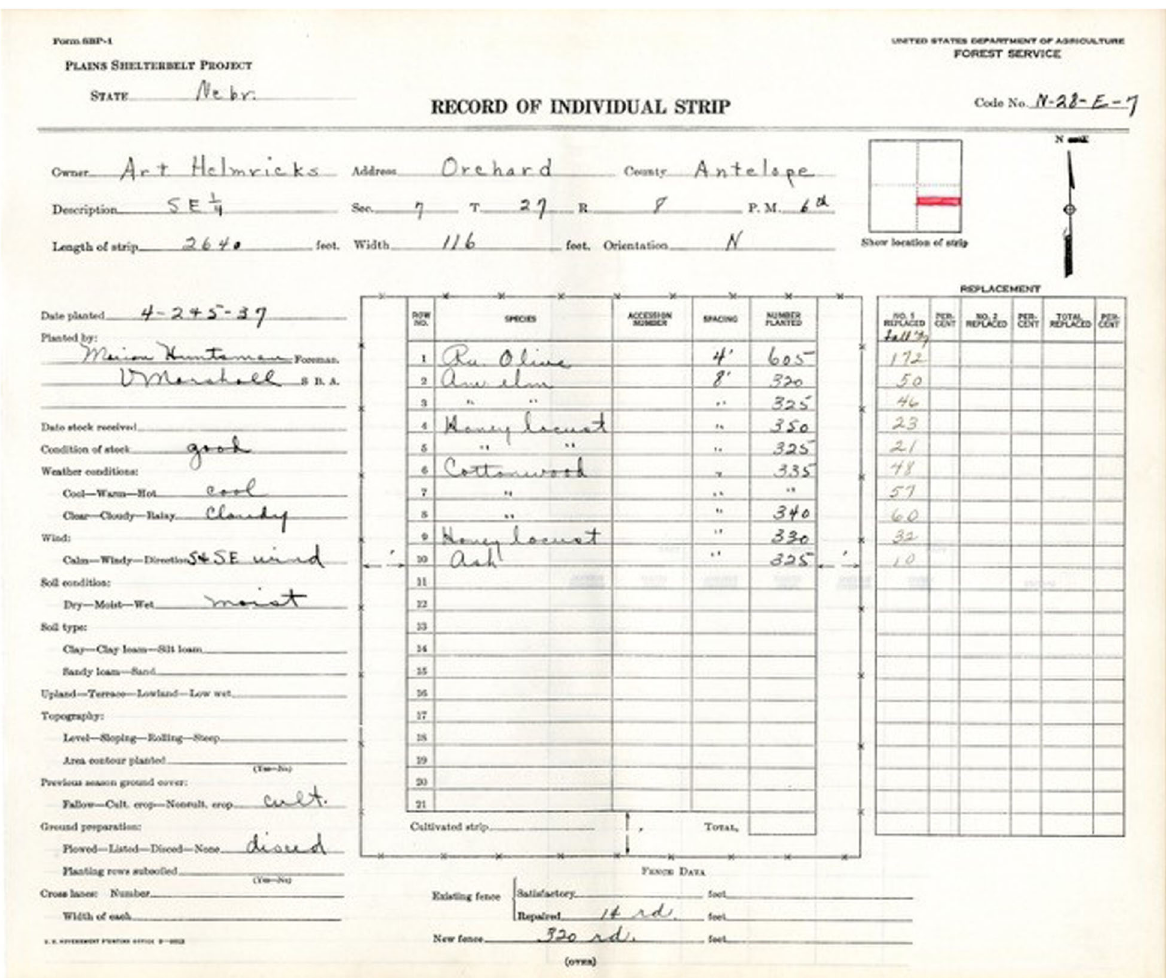
Fig. 11 Archival Source Record of Individual Planting. US Department of Agriculture, Forest Service. (Source: National Agroforestry Centre – Forest